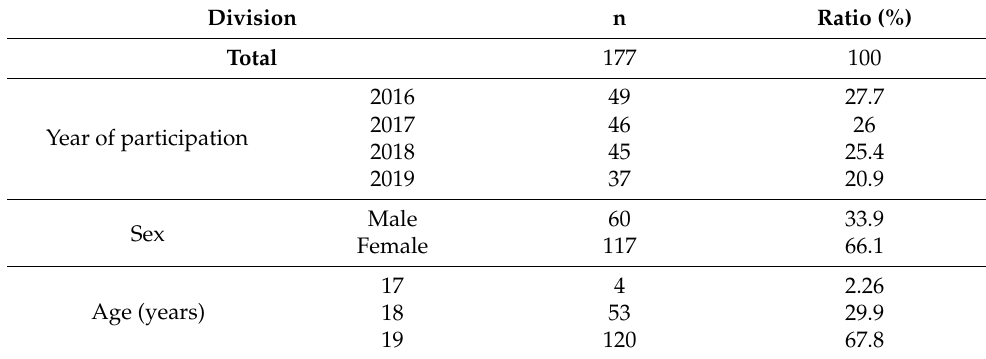
Table 1. Characteristics of the major experience program